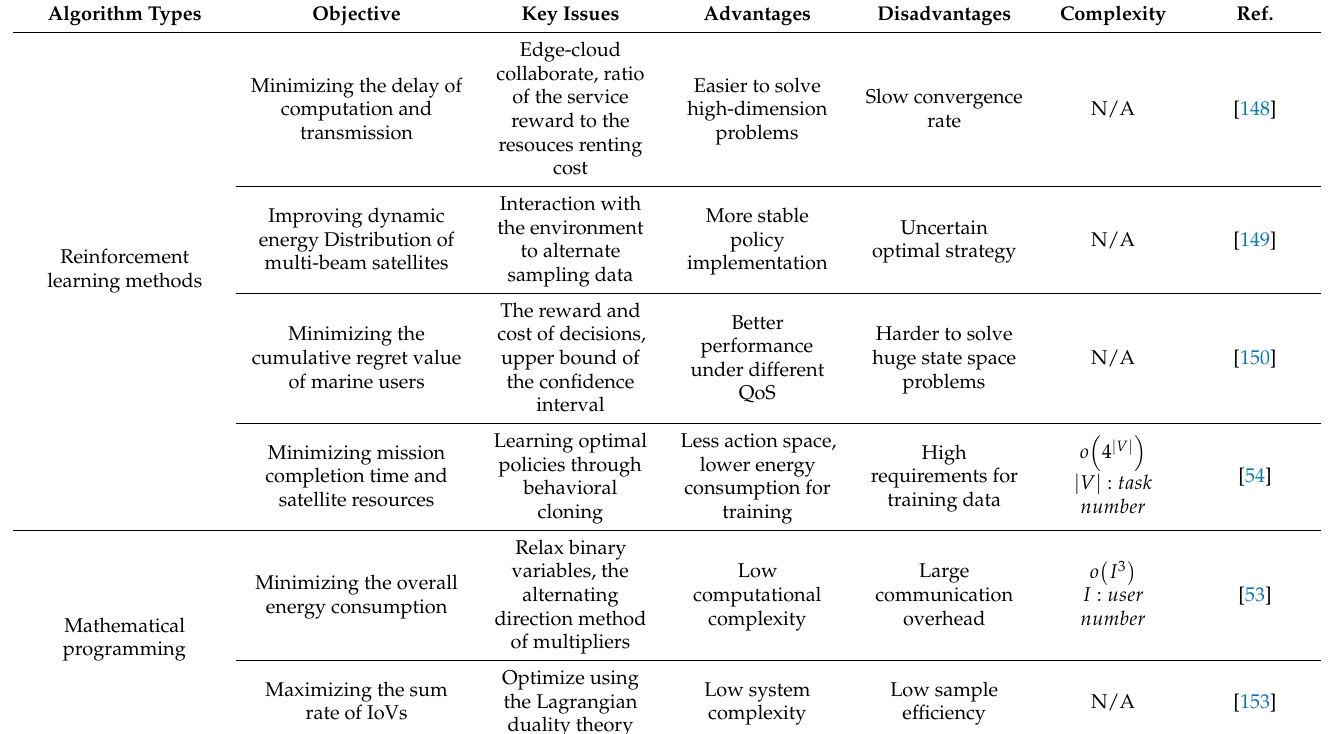
Table 4. Summary of related works on SAGIN key